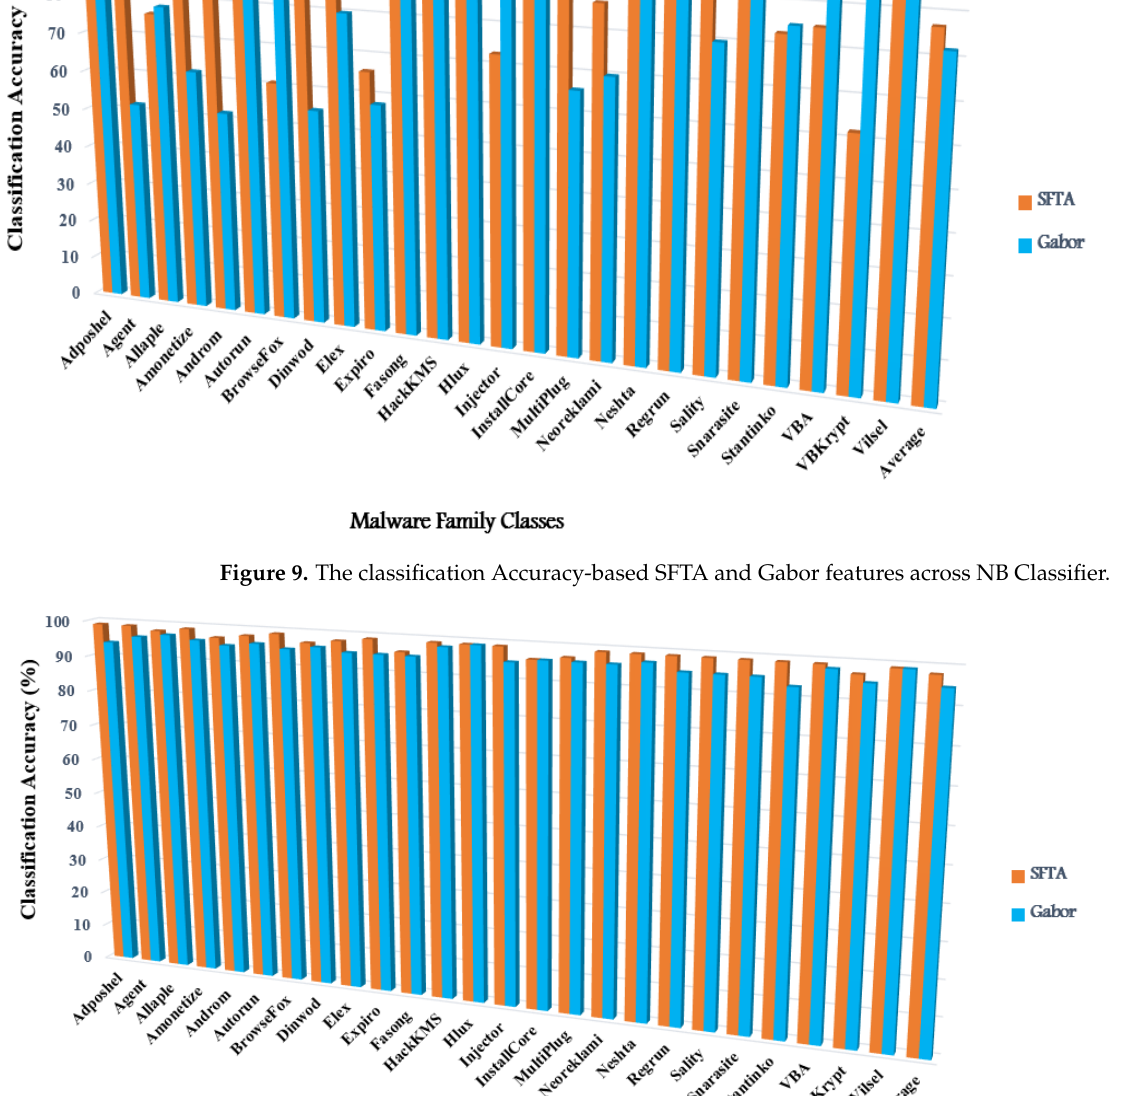
Table 5. Comparative Findings of current MD/MC Methods.